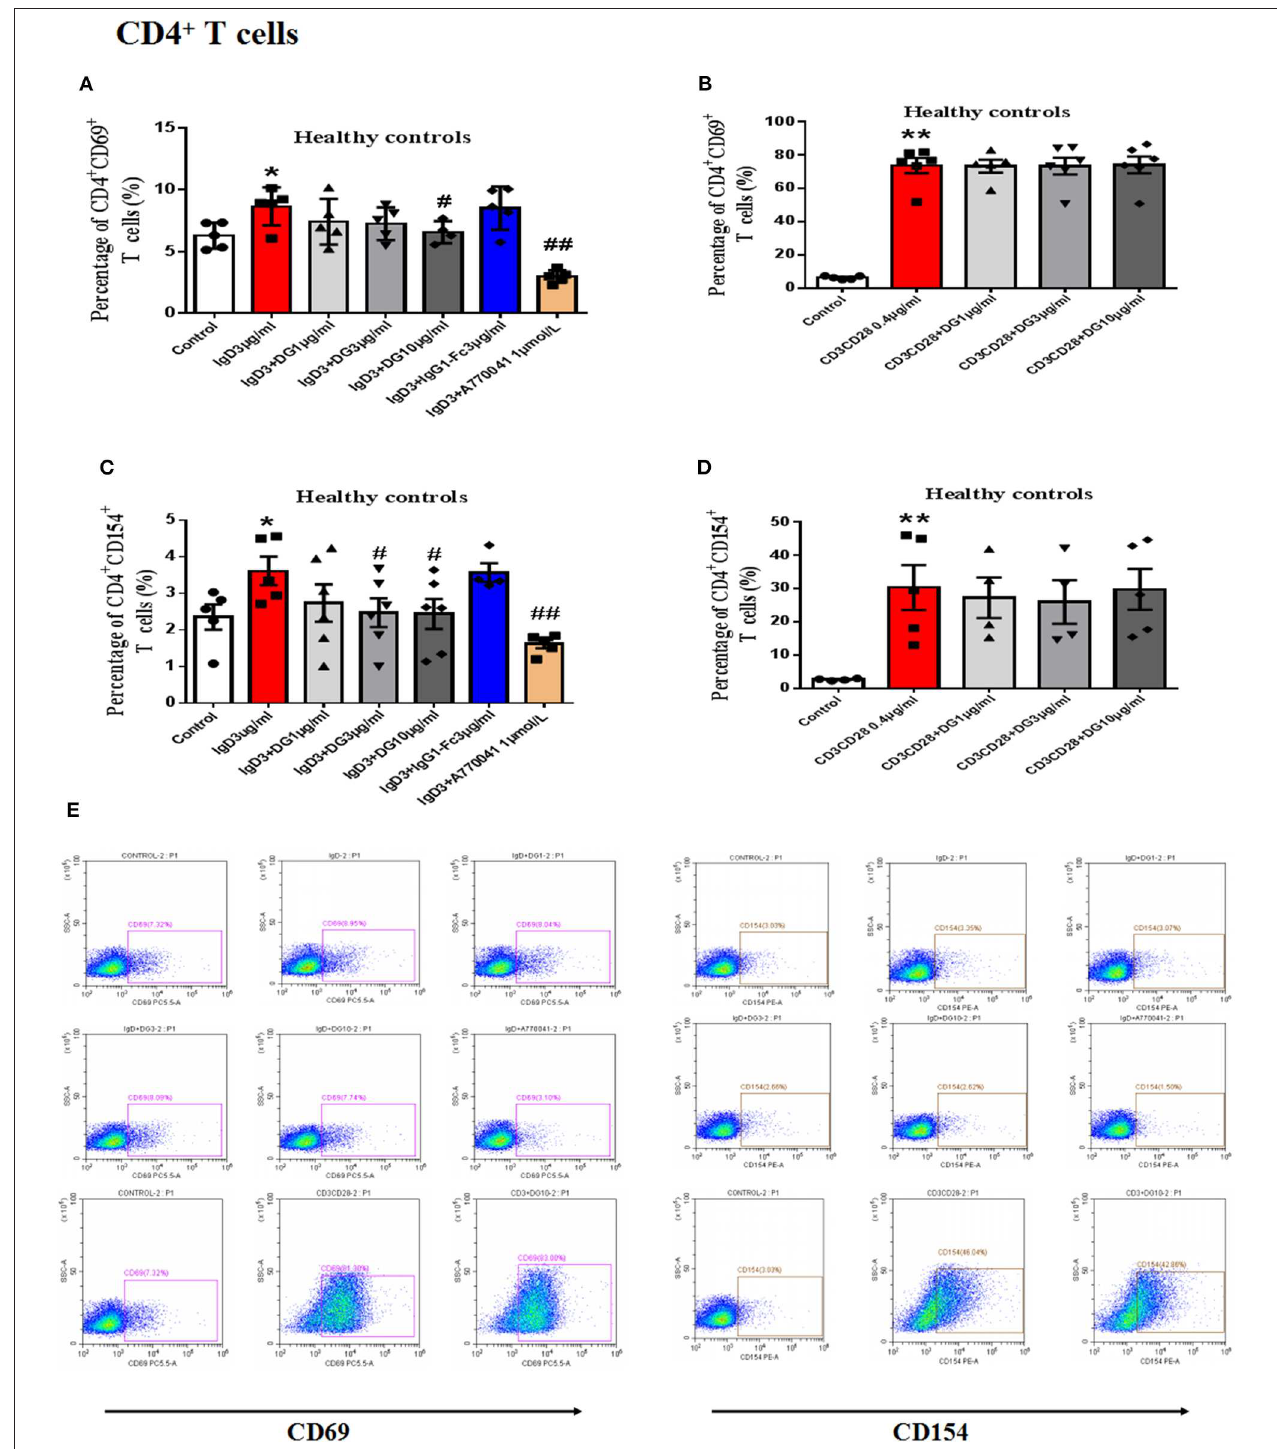
FIGURE 3 | Effects of IgD-Fc-Ig (DG) on the functions of T cells in healthy controls induced by IgD. T cells were incubated with IgD (3 µ g/mL) and different concentrations of IgD-Fc-Ig (1, 3, and 10 µ g/mL) for 48h. (A) Percentage of CD4 + CD69 + T cells treated with IgD-Fc-Ig. (B) Percentage of CD4 + CD69 + T cells treated with anti-CD3CD28 antibodies. (C) Percentage of CD4 + CD154 + T cells treated with IgD-Fc-Ig. (D) Percentage of CD4 + CD154 + T cells treated with anti-CD3CD28 antibodies. (E) Representative flow cytometry dot plot from each group. Data were expressed as mean ± SEM (n = 3-5). * P < 0.05 and ** P < 0.01 vs. control, # P < 0.05 and ## P < 0.01 vs. IgD (3 µ g/mL) group.